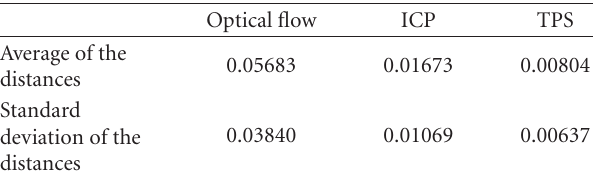
Table 1: The average and standard deviation of the distances between the correspondent points on the source 3D face and destination 3D face. Optical flow ICP TPS 0.05683 0.01673 0.00804 distances 0.03840 0.01069